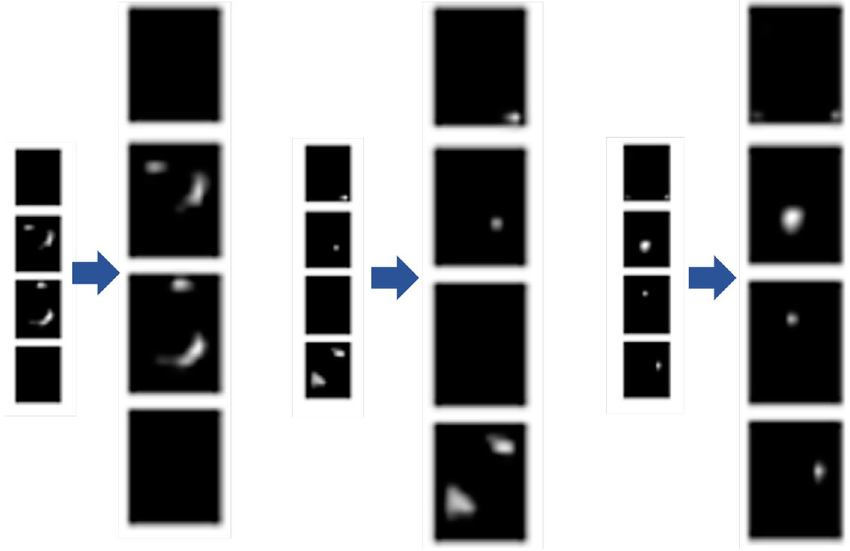
Figure 9. Visualization of the amplified feature map. Amplification is performed by bicubic interpolation.